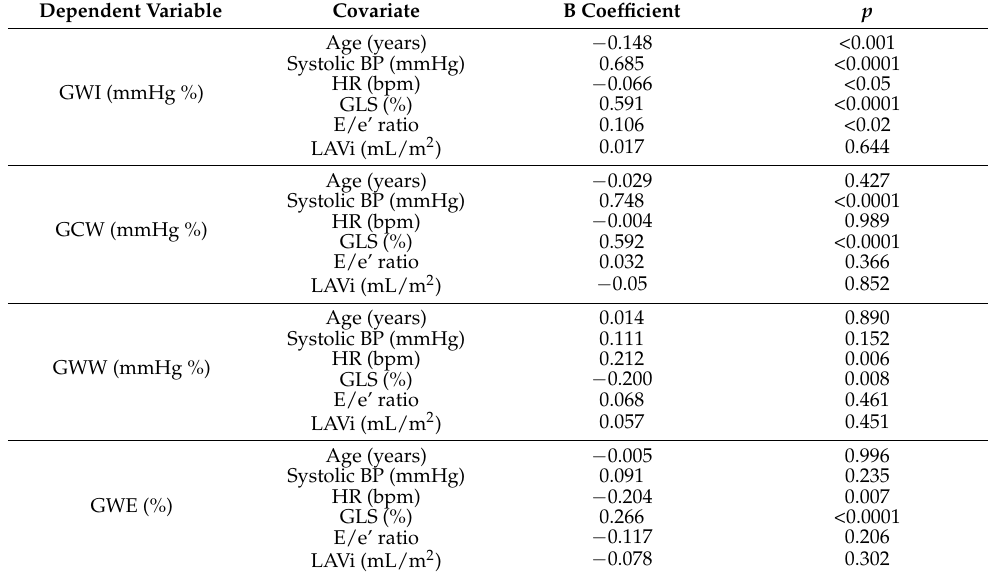
Table 3. Independent determinants of MW components by multiple linear regression analyses. Dependent